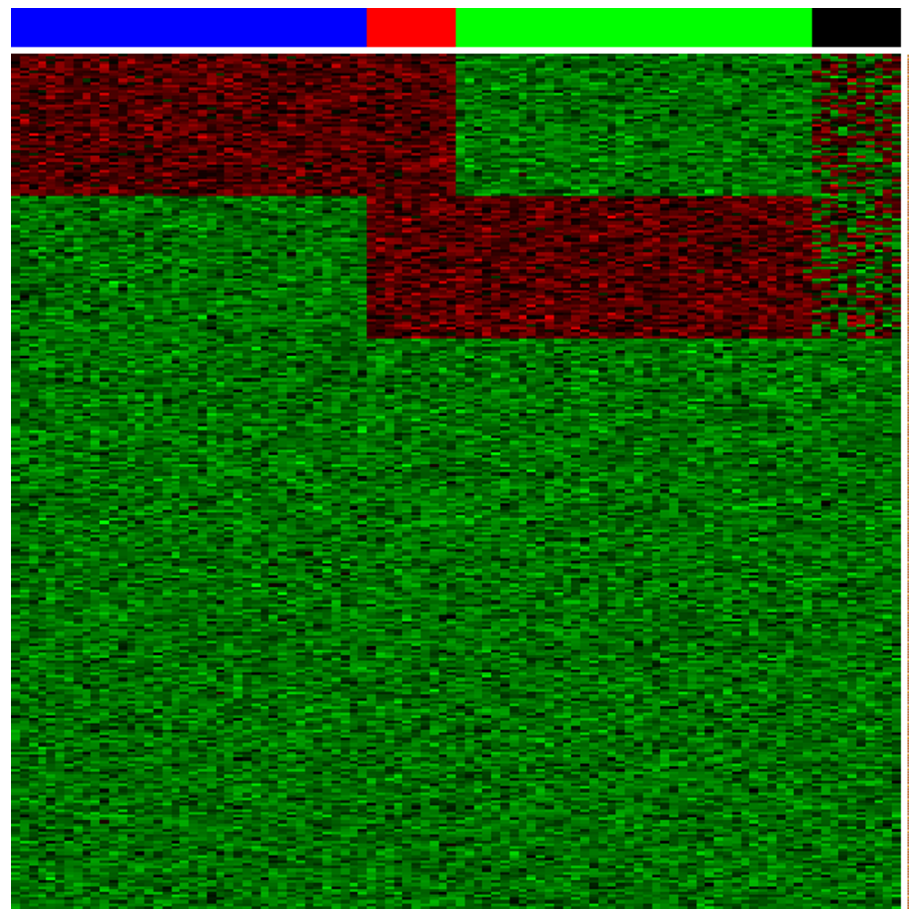
Figure 2. A synthetic 300 6 100 data matrix consists of two main bicluster regions with the size of 50 6 50 having 10 overlapping columns. The columns represent 100 samples consisting of 4 subgroups: S1 (columns 1–40, blue), S2 (columns 41–50, red), S3 (columns 51–90, green), and S4 (columns 91–100, black); the first 100 rows represent attributes: G1 (rows 1–50), G2 (rows 1–100), G3 (rows 51–100), and G4 (rows 1– 100).